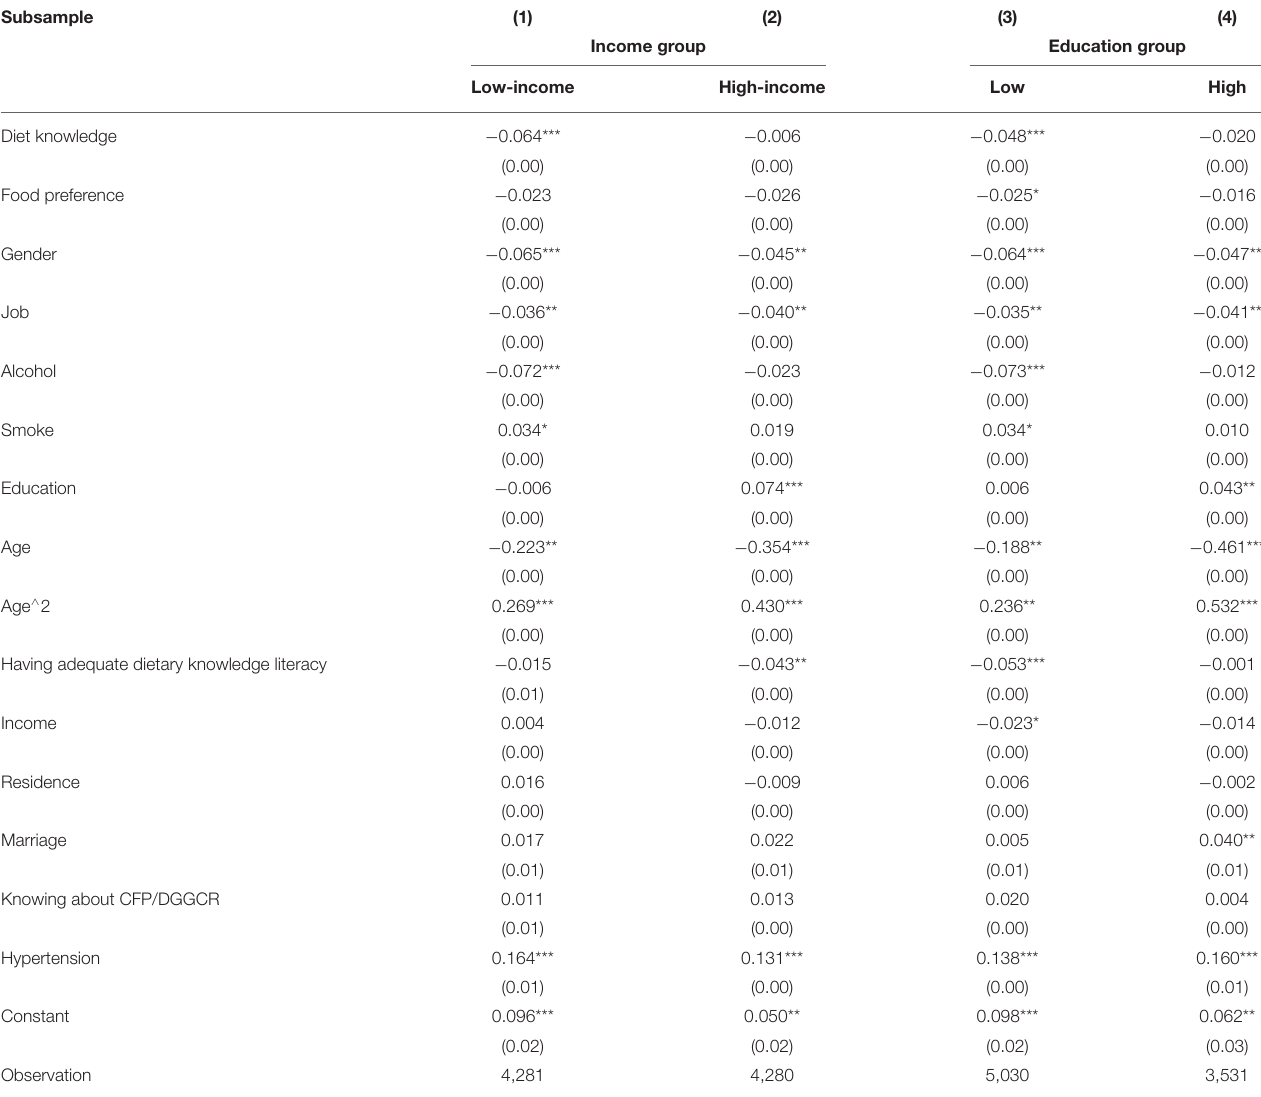
TABLE 4 | OLS estimates-effect of diet score on stroke by income group & education group.